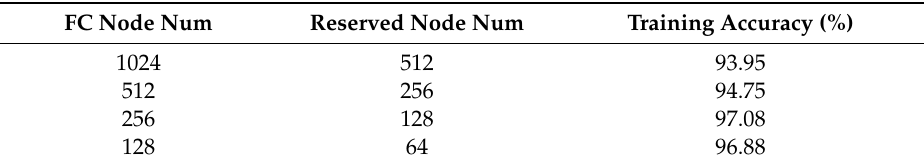
Table 4. Accuracy of the training data set from four different models.